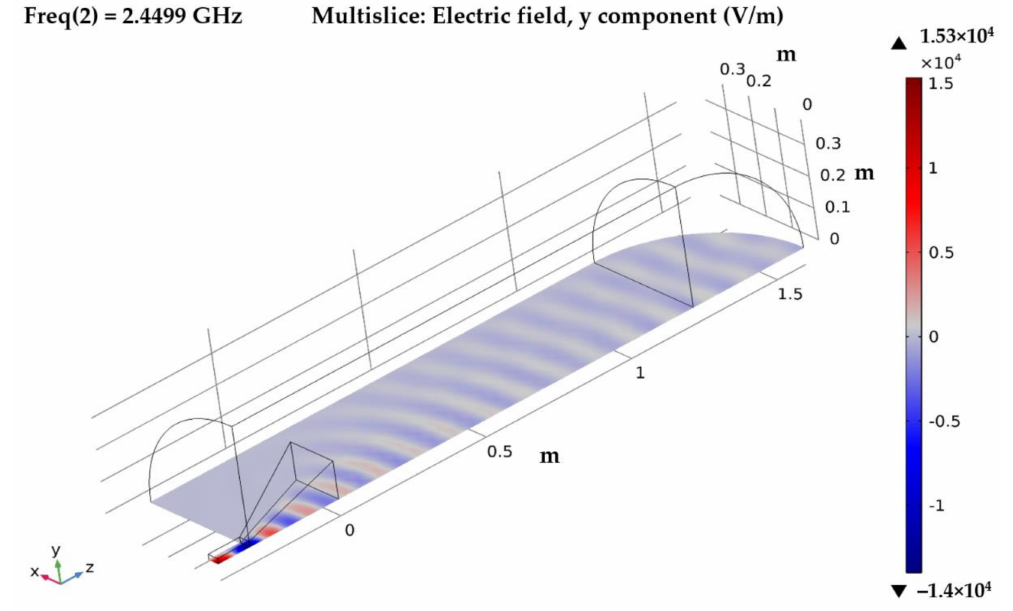
Figure 14. Simulation results - E-field dependence on the distance in COMSOL Multiphysics. Figure 15 shows Ey components of the E-field dependence on the distance obtained by calculation (Equations (1) and (2)) and simulations. Figure 15a shows a full view of the Ey component, including the E-field in the waveguide zone, in the pyramidal horn antenna zone and in the reactance zone. Figure 15b shows a detailed view of the Ey component in the measured zone.